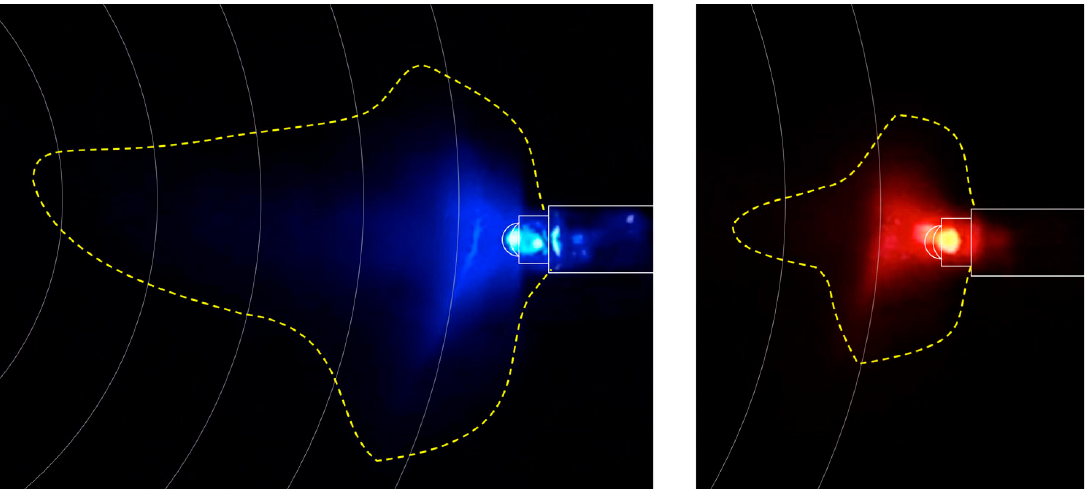
Figure 2. Light cones emitted by the diodes. Section of screenshots of videos taken during experiment #3 (mono color experiments). The dotted line indicates the range of the light cone as determined via an extreme enhancement of shadows in Photoshop. The concentric circles indicate distances (in 25 mm intervals) from the center (compare Figure 4).